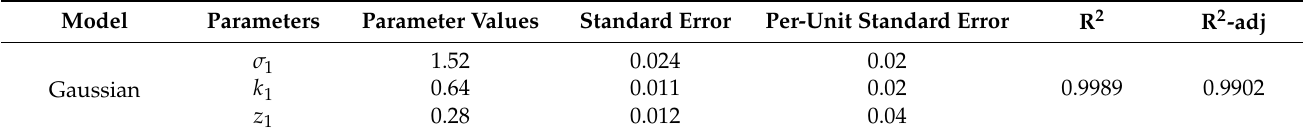
Figure 6. Comparing the Gaussian model with experimental measurement ( a ) n = 1 ( b ) n = 2. Table 4. Gaussian fitting performance data (n = 1).